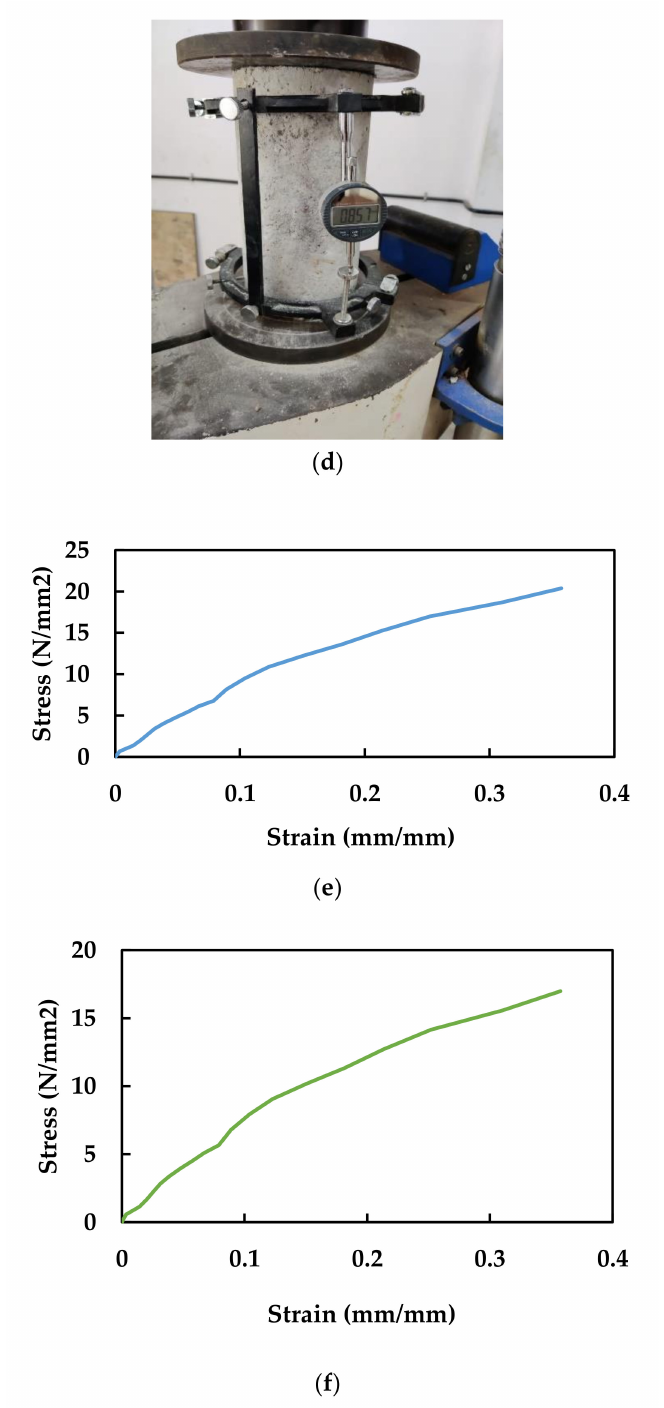
Figure 7. ( a ) Split tensile strength; ( b ) split tensile strength testing machine; ( c ) flexural strength test; ( d ) compression test of cylinder specimens with compressometer; ( e ) stress–strain behavior of conventional concrete; ( f ) stress–strain behavior of